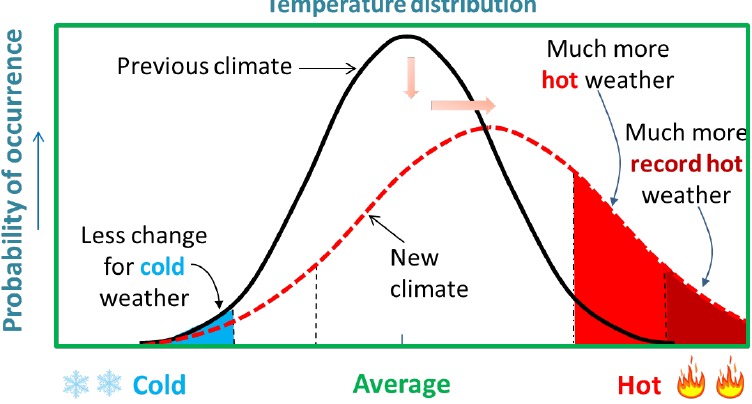
Figure 3. The temperature change between previous years and recent years [1].